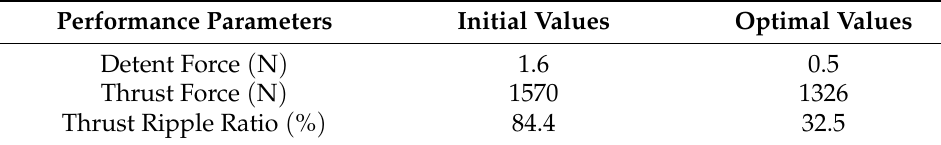
Table 3. Performance analysis before and after parametric